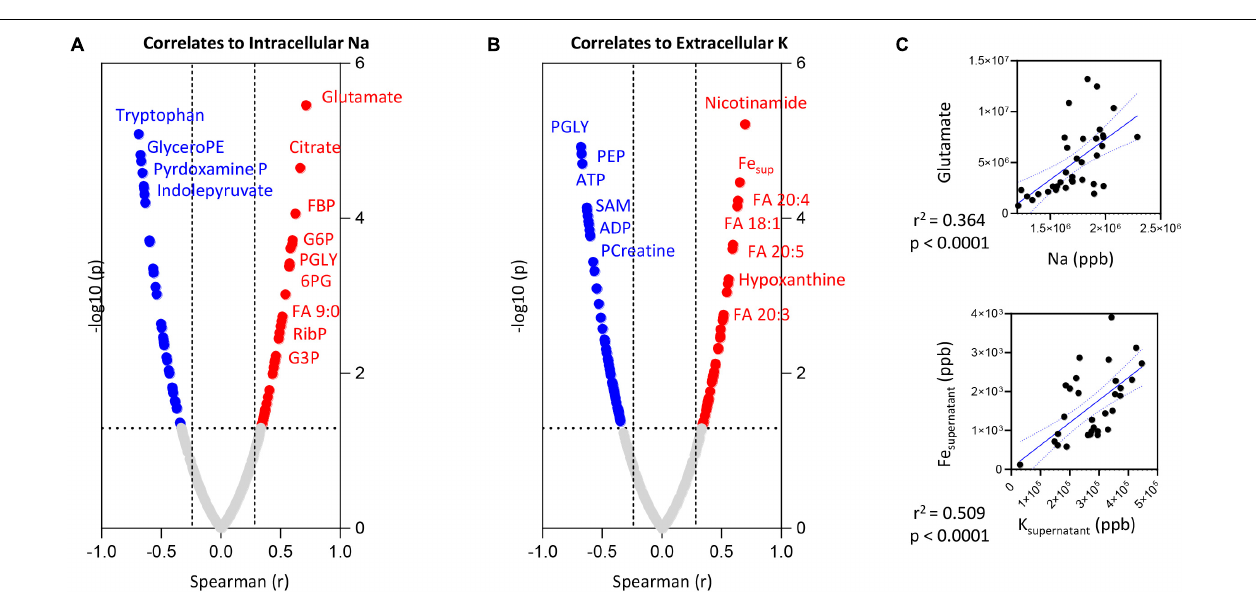
FIGURE 4 | Correlation of intracellular (A) or extracellular (B) calcium levels to RBC or superantant metabolites. In panel (C) , highlighted correlations curves for Mg and Ca (intracellular) and Lactate and Ca (supernatant).